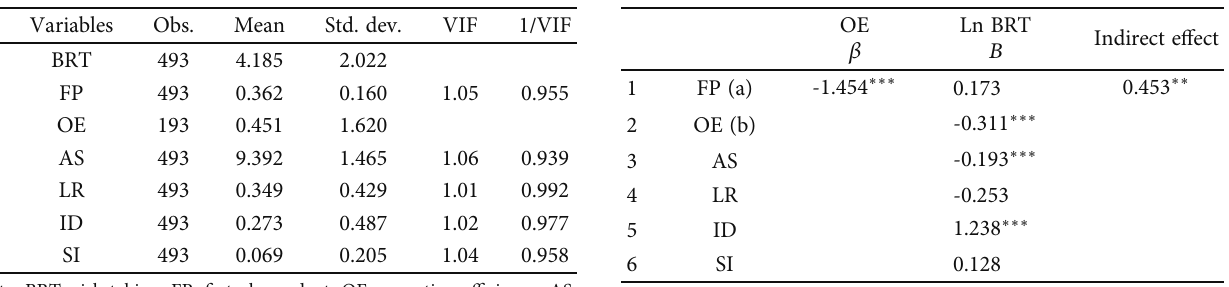
Table 3: Summary statistics.